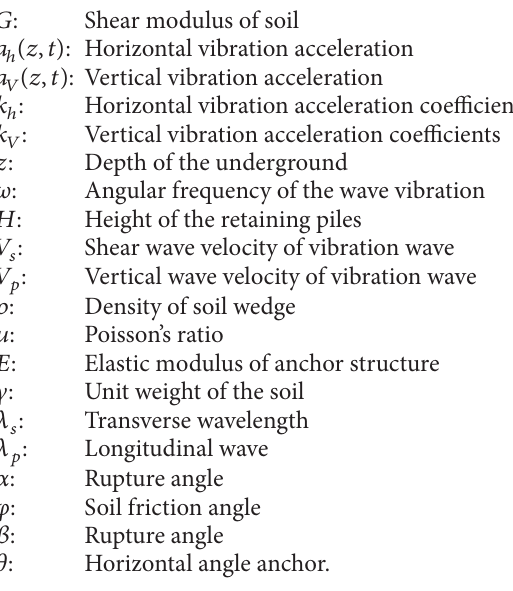
deep pits. The proposed solution incorporates vibration